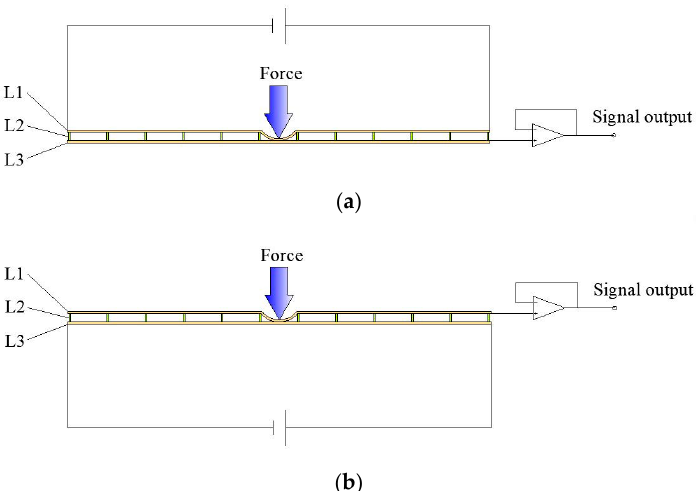
Figure 2. Cross-section of the sensor. ( a ) Position detection of the X axis. ( b ) Position detection of the Y axis.